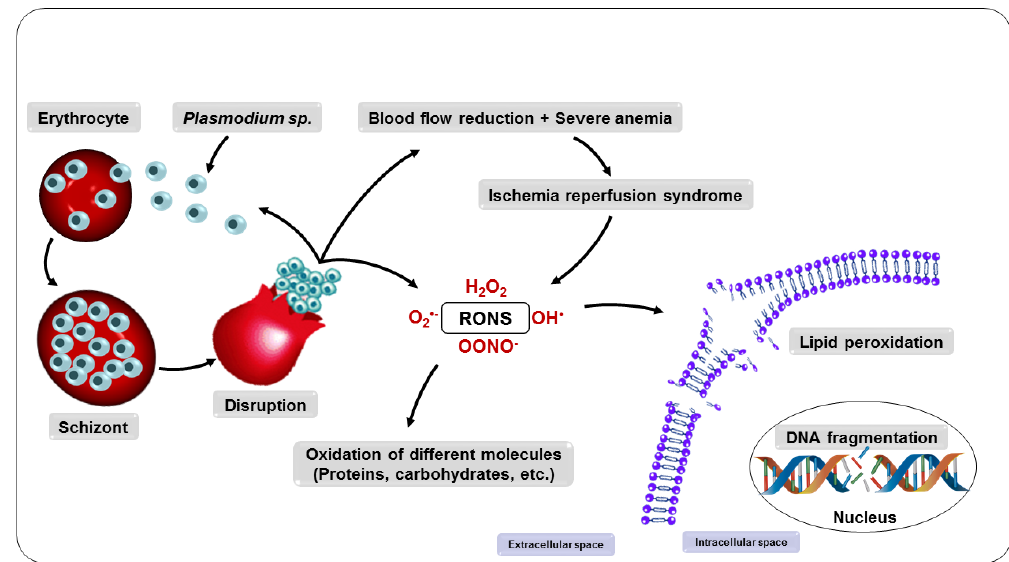
Figure 5. Consequences of the multiplication of parasites in the erythrocyte.